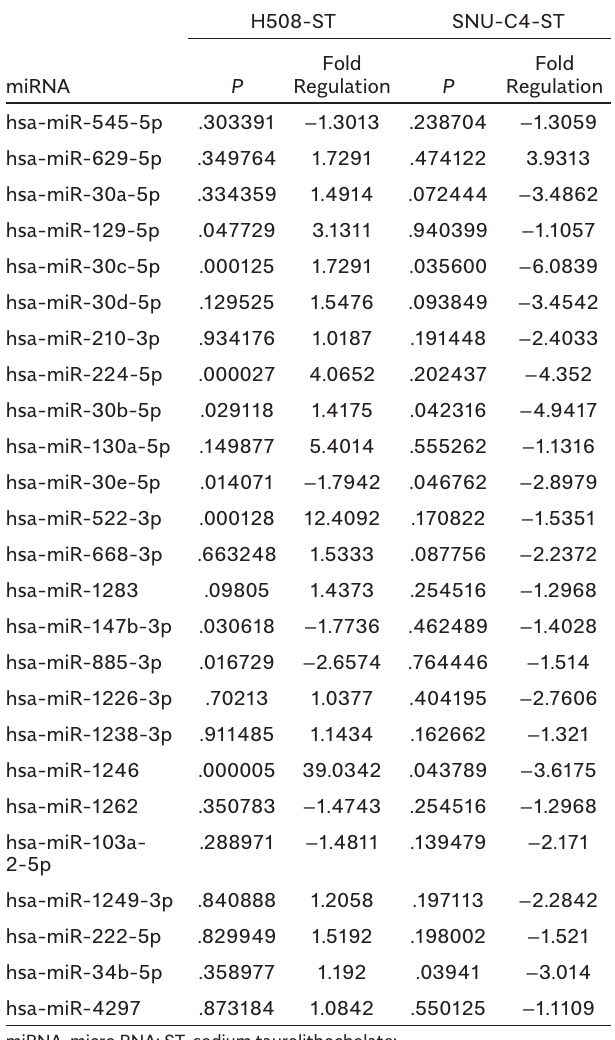
Table 1. miRNA Alterations in Response to ST Treatment in the Colon Cancer Cell Lines miRNA